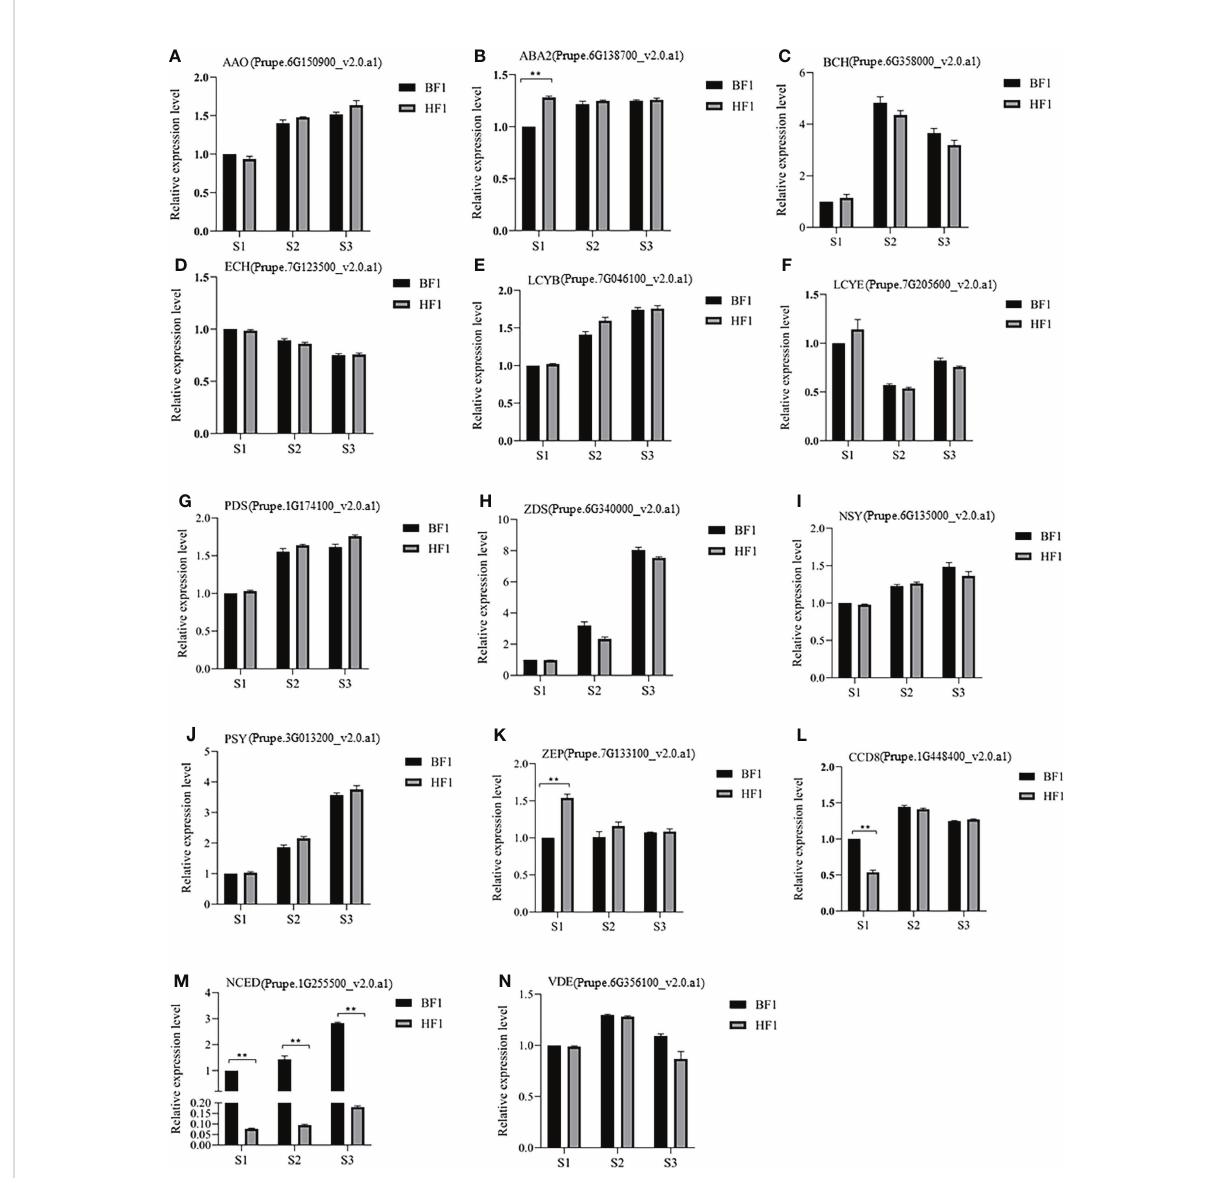
FIGURE 8 qRT-PCR analysis of the expression of genes related with carotenoids metabolism in BF1 and HF1 at fruit development stages. (A) AAO. (B) ABA2. (C) BCH. (D) ECH. (E) LCYB. (F) LCYE. (G) PDS. (H) ZDS. (I) NSY. (J) PSY. (K) ZEP. (L) CCD8. (M) NCED. (N) VDE. Data were presented as the means±standard error of three biological replicates, *means signi fi cant difference at p < 0.05 by t-test; ** means signi fi cant difference at p < 0.01 by